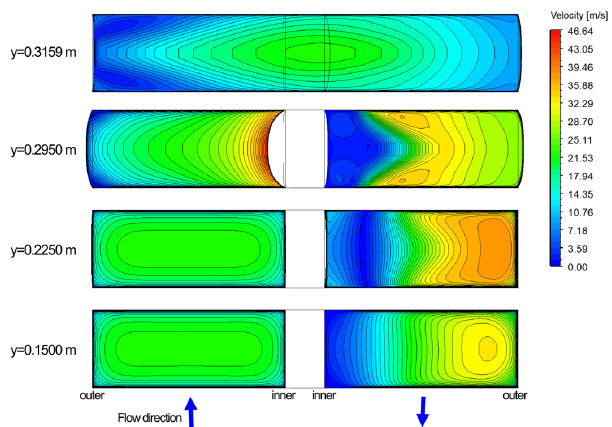
Figure 15. Velocity contour using the adjoint solver at different heights (Re = 24,230). Figure 16 shows the velocity contour at the center of the x-coordinate; when compared to Figure 8, the velocity was the lowest near both ends of the top of the divider, and the high velocity region moved closer to the top of the divider.